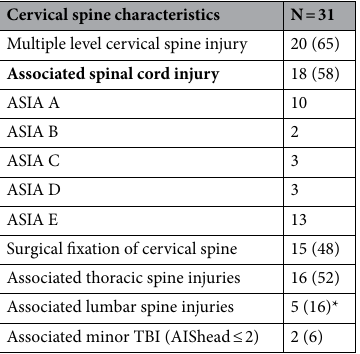
Table 2. Characteristics of cervical spine specific injury. Data are expressed in absolute numbers (%). ASIA American Spinal Injury Association, TBI traumatic brain injury, AIS Abbreviated Injury Scale. *1 patient had injuries in both thoracic and lumbar spine.